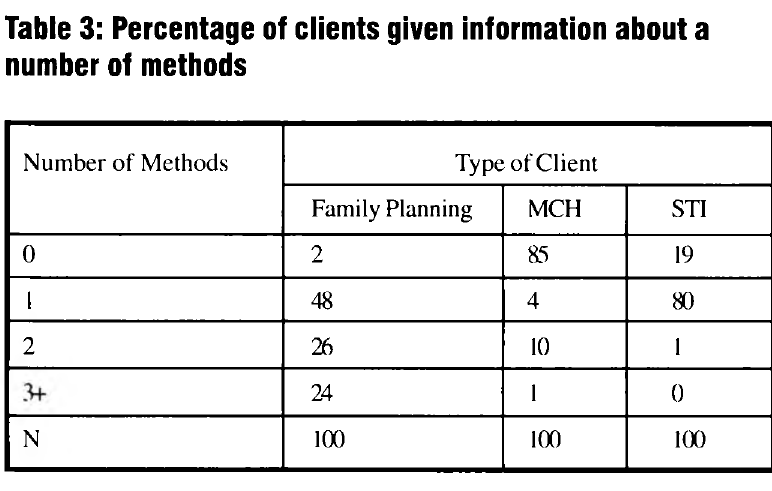
Table 3: Percentage of clients given information about a number of methods